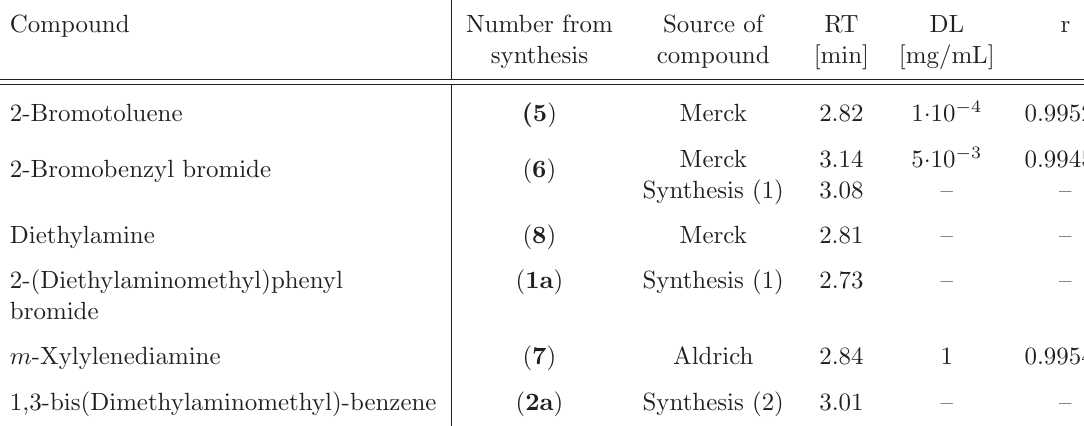
Table 1 Retention times, detection limits and regression factors for studied